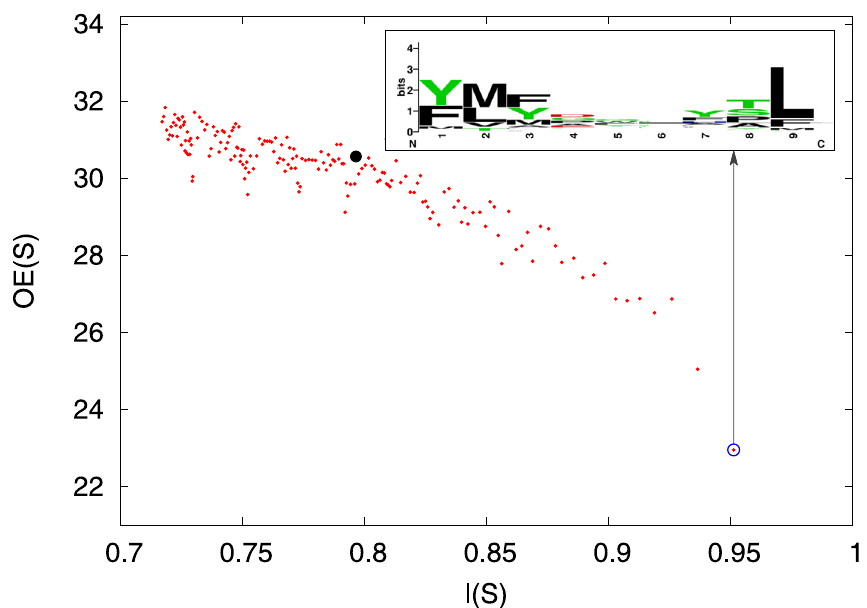
Fig 5. Overall entropy values, OE ( S ), for disjoint peptides set of Trypanosoma cruzi, S , (increasingly ordered according to the score l ) plotted against the average score in the set, l ( S ). The black point is the entropy value associated to the 100 top ranking W 4 peptides of Trypanosoma cruzi while the circled point at the bottom right represents the entropy value associated to the most promising 100 peptides selected from the whole set TC. In the associated inset it is shown the logo plot for this last